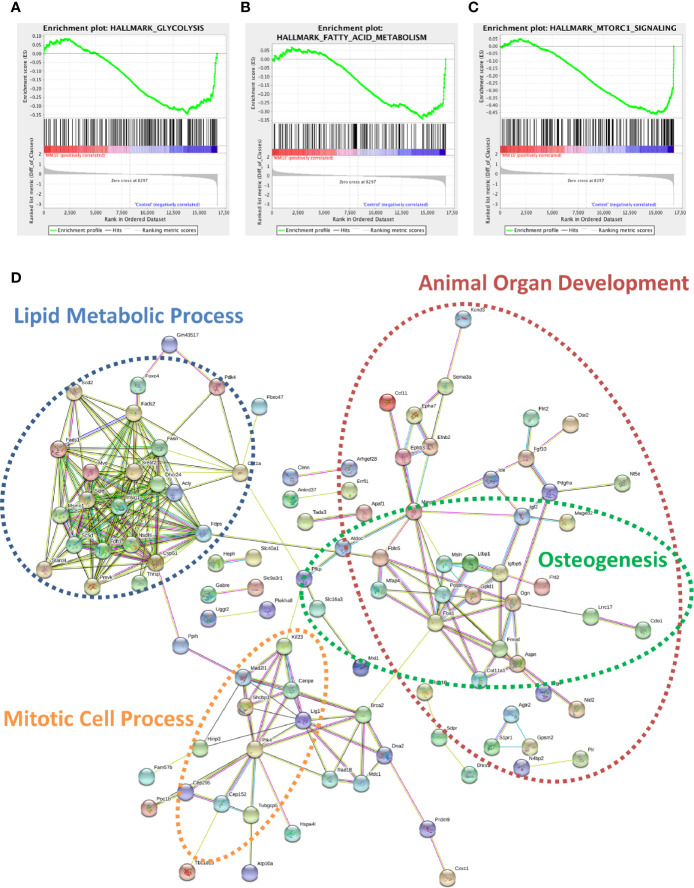
Cellular metabolism and key signaling pathways are altered in myeloma-associated mouse adipocytes. 3T3-L1 adipocytes exposed to MM.1S prior to differentiation have altered expression of genes involved with glycolysis (A), fatty acid metabolism (B), and mTORC signaling (C) as determined via gene set enrichment analysis (GSEA) analysis of 3T3-L1 microarray data. Expression of genes involved in lipid metabolism and encoding essential growth factors are downregulated in MM-3T3-L1 adipocytes (D) as visualized by string-db analysis of 3T3-L1 microarray data (p < 0.05, FC<−1.5).